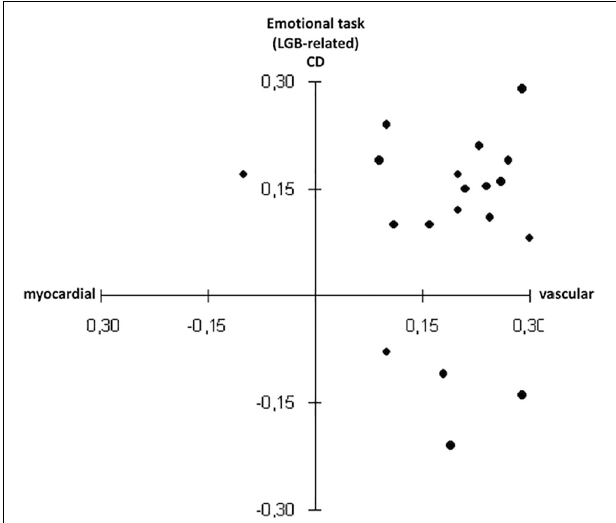
FIGURE 2 | Scatterplots for hemodynamic profile and compensation deficit during the lesbian, gay and bisexual (LGB)-related task in the LGB